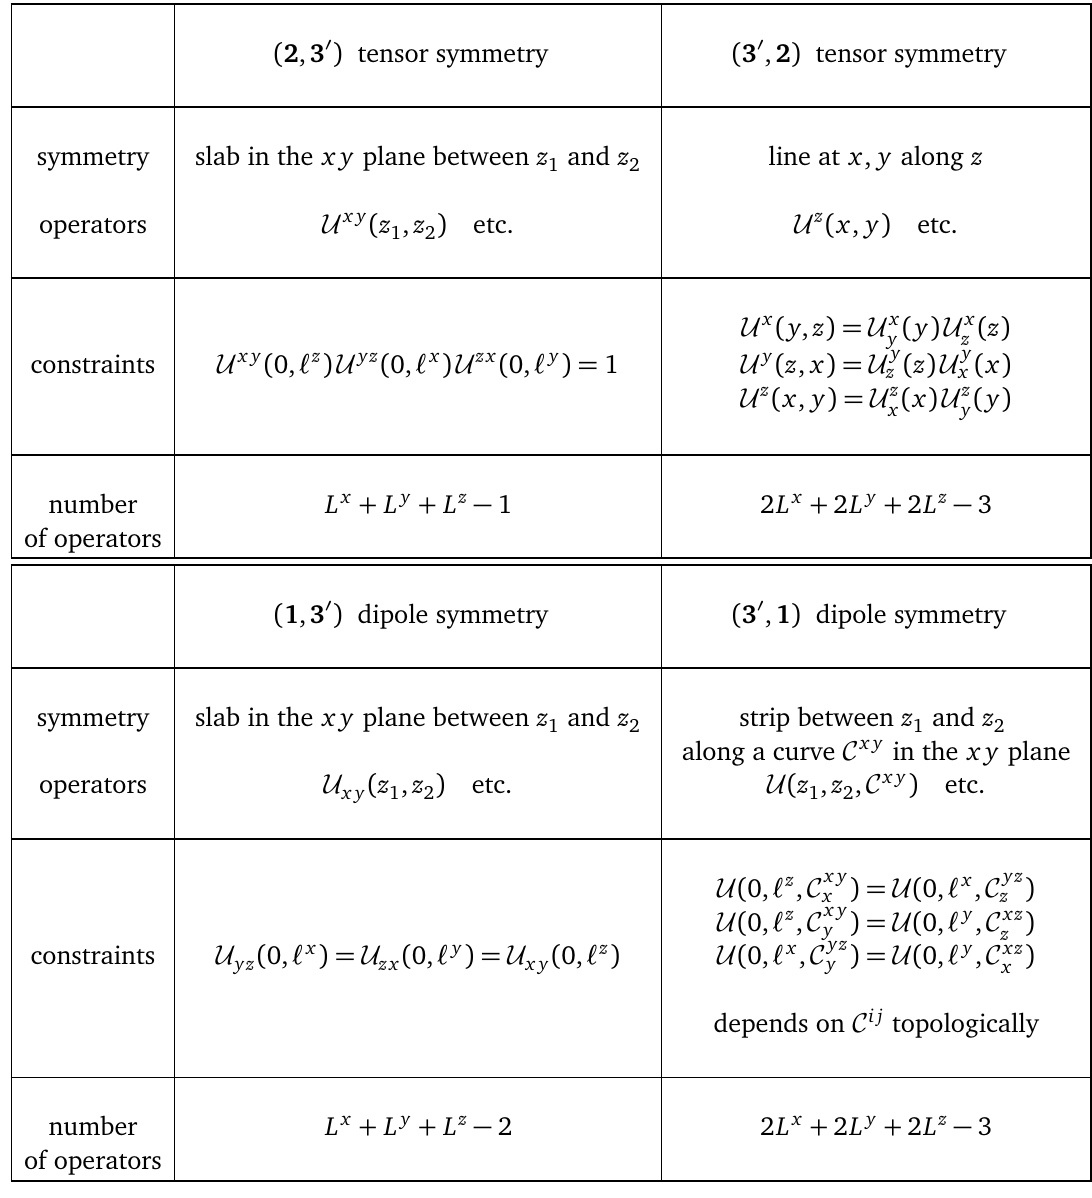
Table 1: The symmetry operators of the tensor and dipole global symmetries. We also show the number of these operators when we discretize the space to a lattice with L x , L y , L z sites in the three directions. For simplicity we wrote the symmetry oper- ators for a single direction and added “etc." to represent the other directions. Every slab operator with argument ( 0, (cid:96) x ) etc. acts on the whole space. We further define the ( 3 (cid:48) , 2 ) unconstrained tensor and the ( 3 (cid:48) , 1 ) unconstrained dipole symmetries by relaxing the constraints above. See [ 2 ] and Appendix B for more details.